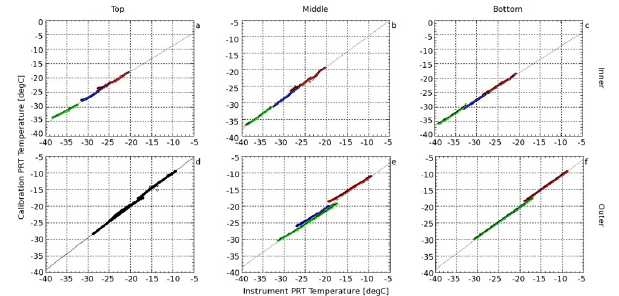
Fig. 5. Temperatures as measured by instrument PRTs (x-axis) plot- ted against temperatures as measured by calibration PRTs ∗ (y-axis) for three different start temperatures ( − 18 ◦ C, − 25 ◦ C, − 30 ◦ C) ∗ Deviations from straight-line fit for outer wall middle tempera- tures was due to calibration sensor not being firmly fixed to the